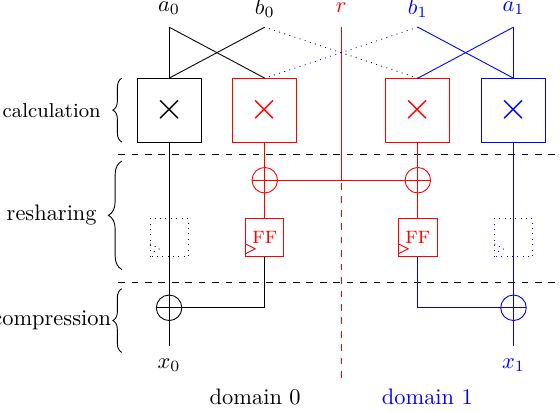
Figure 1: First-order DOM-indep